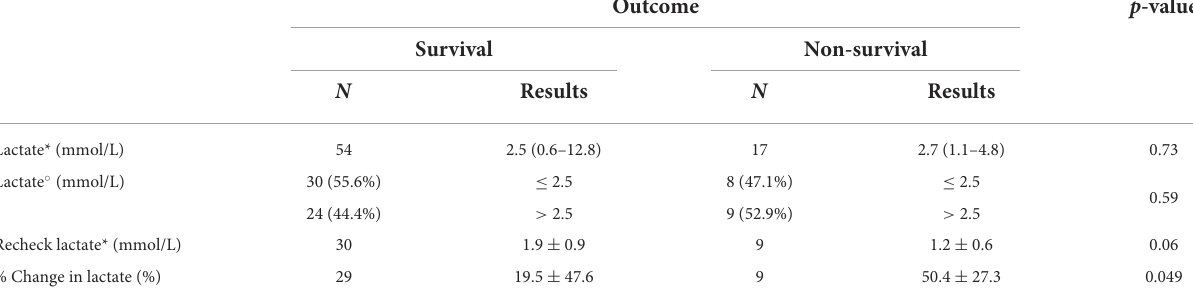
TABLE 2 Prognostic value of admission lactate concentration, recheck lactate concentration, and percent change in lactate concentration in cats presented with respiratory distress to predict outcome (survival vs. non-survival).